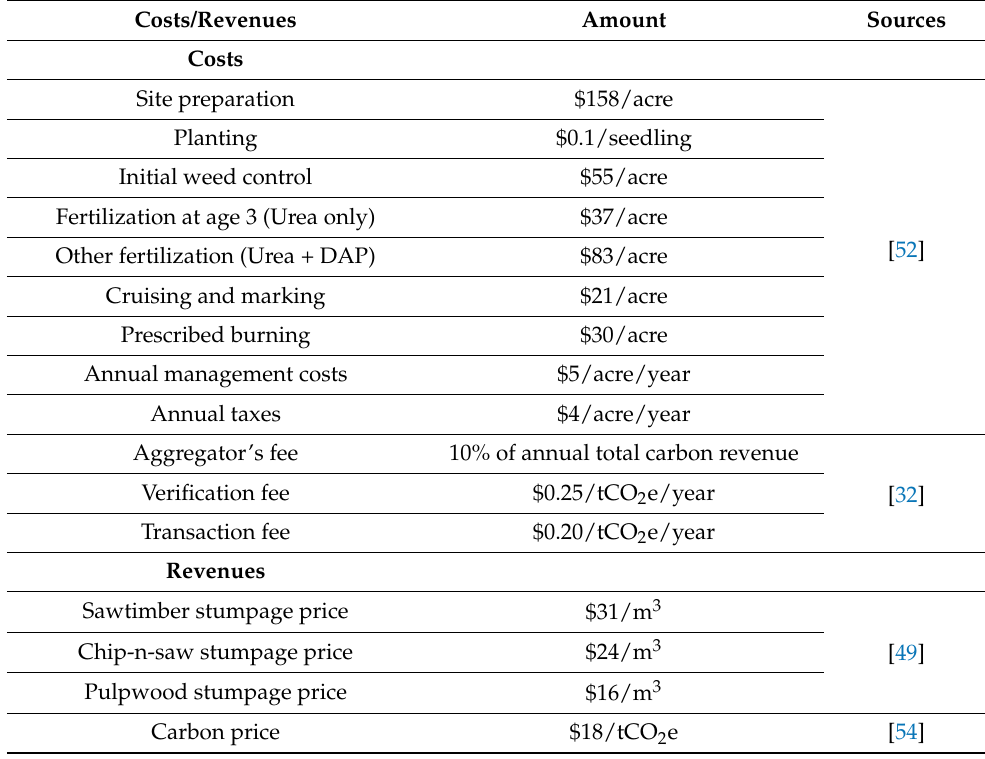
Table 2. Summary of costs and revenues associated with managing slash pine.